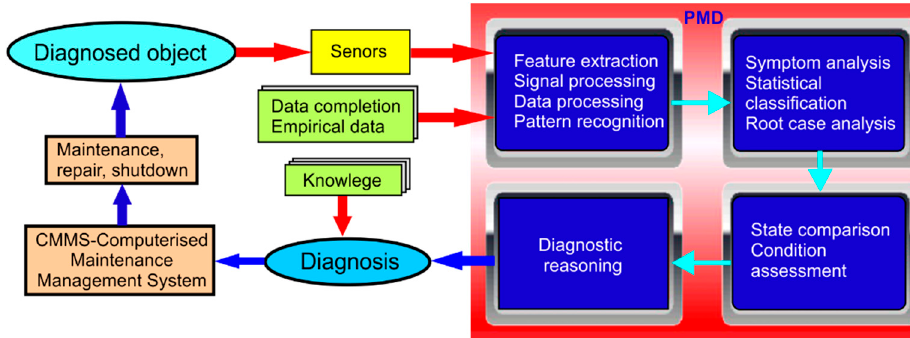
Figure 4. General diagram of the diagnostic process with the use of PMD.